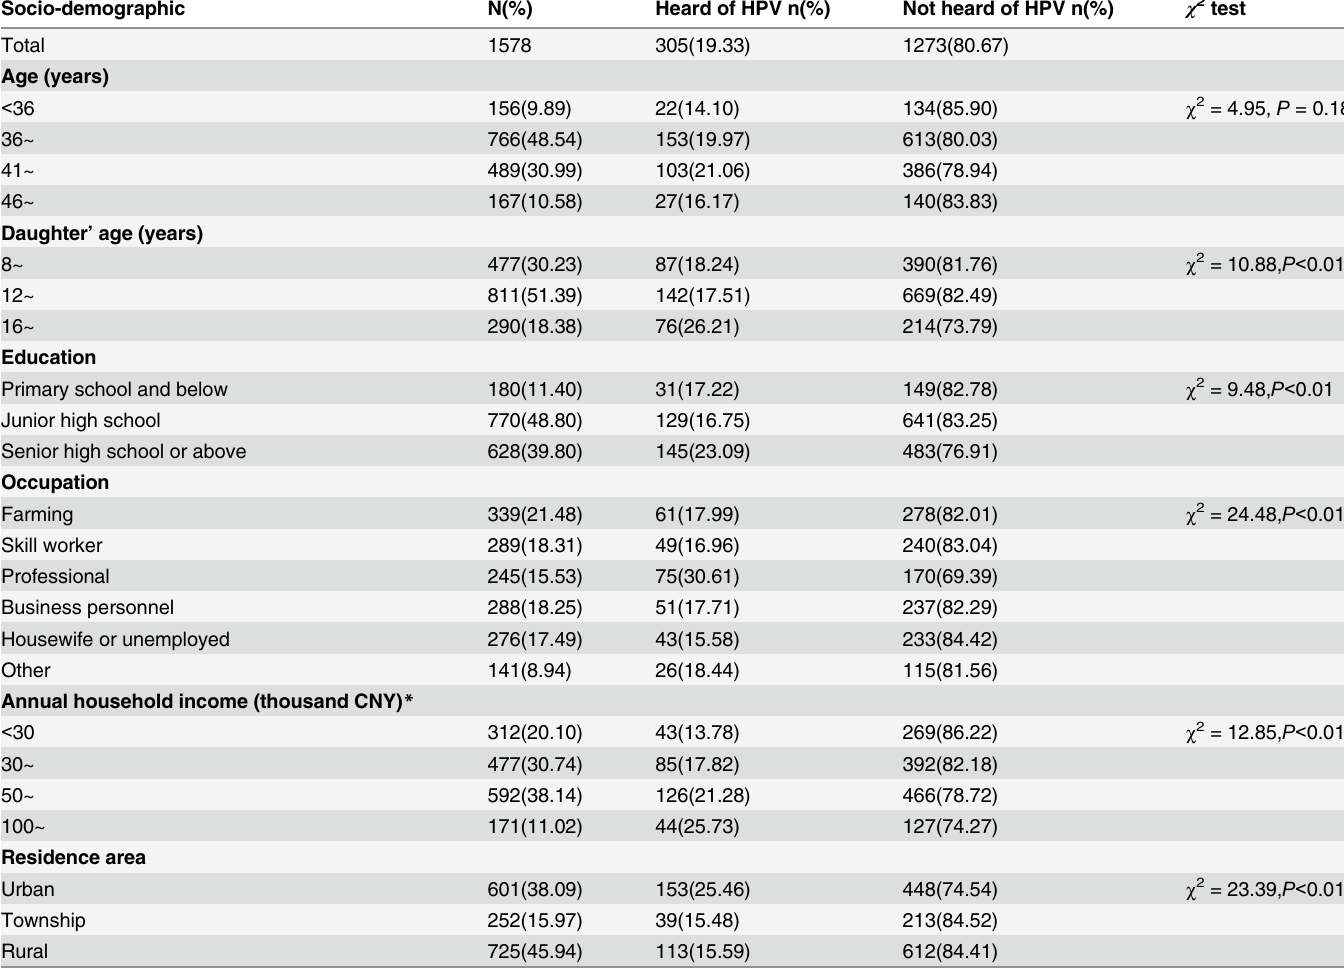
Table 2. The awareness rate of HPV by socio-demographic